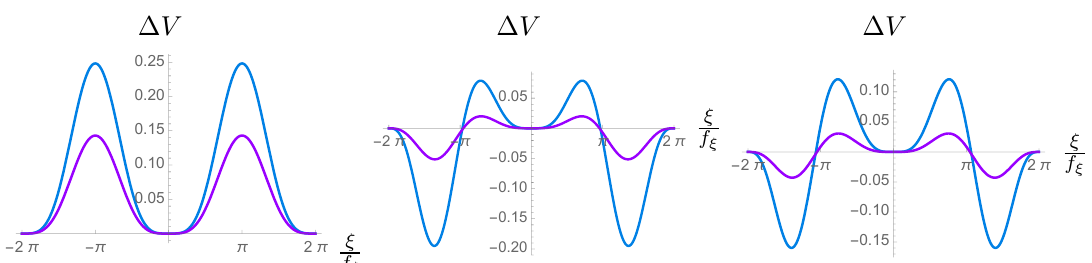
Figure 6 . Comparison (cid:1) V between the non-back-reacted potential and the back-reacted potential as a function of the in(cid:13)aton (cid:24) : the back-reaction due to in(cid:13)adron (cid:27) (left), back-reaction due to in(cid:13)adron (cid:17) (middle) and back-reaction due to both in(cid:13)adrons (cid:27) and (cid:17) (right). The potentials are drawn for parameter choice (cid:22) = 2 (cid:20) = 10 (cid:21) = 10 16 GeV and M = 10 15 GeV (purple) or M = 2 (cid:2) 10 15 GeV